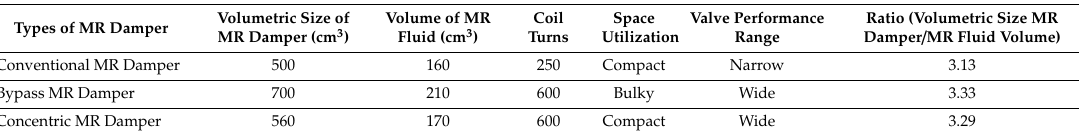
Table 1. Comparison of MR damper designs.